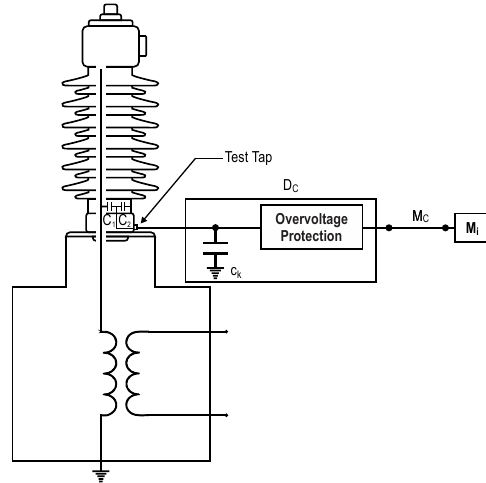
Figure 2. Electrical method scheme for partial discharge measurement.